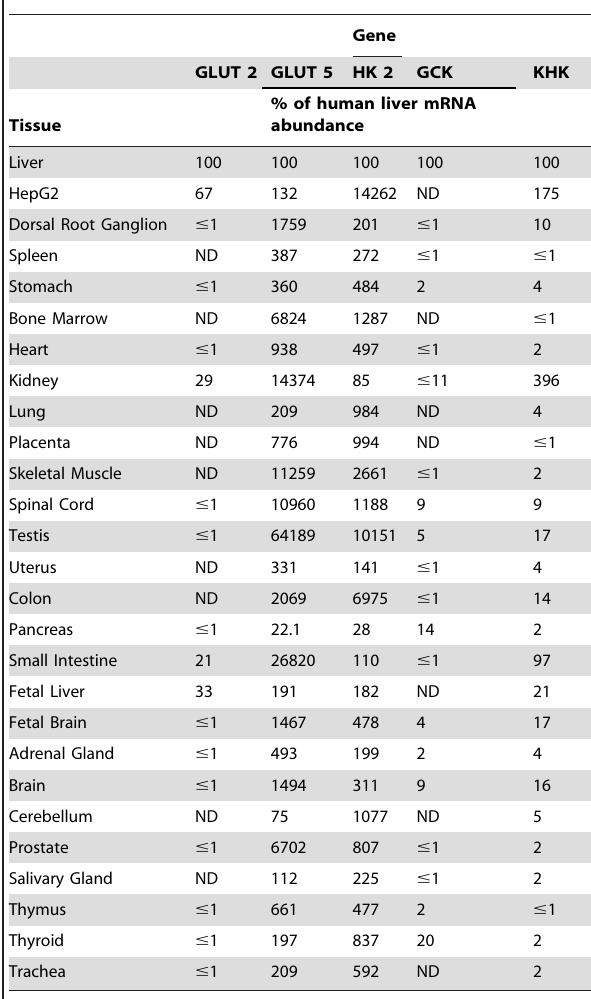
Table 1. mRNA expression profile of transporters and enzymes important for simple carbohydrate catabolism in HepG2 cells and human tissues using real-time